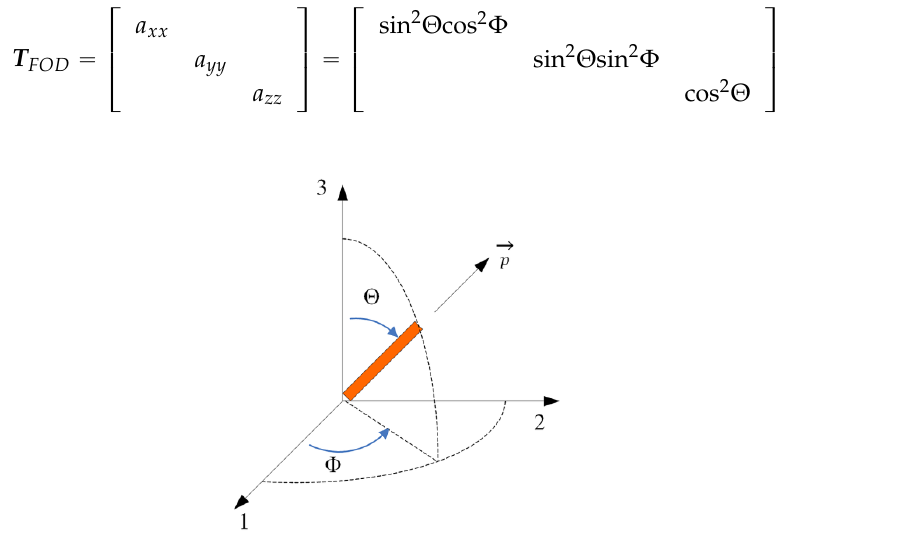
Figure 1. Representation of the solid angle of fiber orientation with respect to axis name according to Advani and Tucker; 1 to denote flow direction x , 2 to denote in-plane transverse to flow direction y and 3 to denote thickness direction z [8].